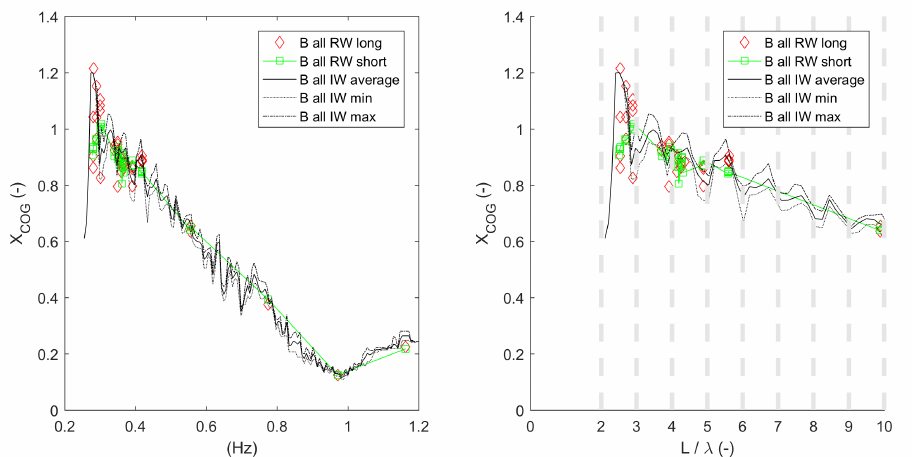
Figure 19. Surge RAOs from regular and irregular waves in basin B (as function of frequency ( left ) and ratio of basin’s length by wave length ( right ).